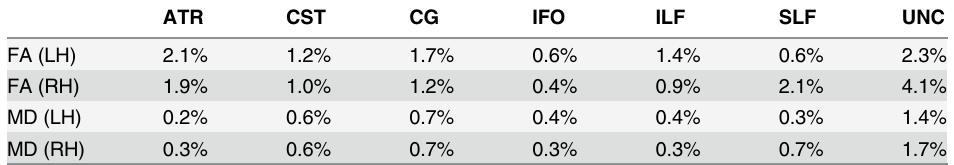
Table 2. Comparison of diffusion properties (FA,MD) between manually and automatically labeled bundles. ATR CST CG IFO ILF SLF UNC FA (LH) 2.1% 1.2% 1.7% 0.6% 1.4% 0.6% 2.3% FA (RH) 1.9% 1.0% 1.2% 0.4% 0.9% 2.1% 4.1% MD (LH) 0.2% 0.6% 0.7% 0.4% 0.4% 0.3% 1.4% MD (RH) 0.3% 0.6% 0.7% 0.3% 0.3% 0.7% 1.7% Comparison is done by computing the ratio of the FA(MD) difference to the FA(MD) of manually labeled bundles. The ratio is averaged over the values of twelve